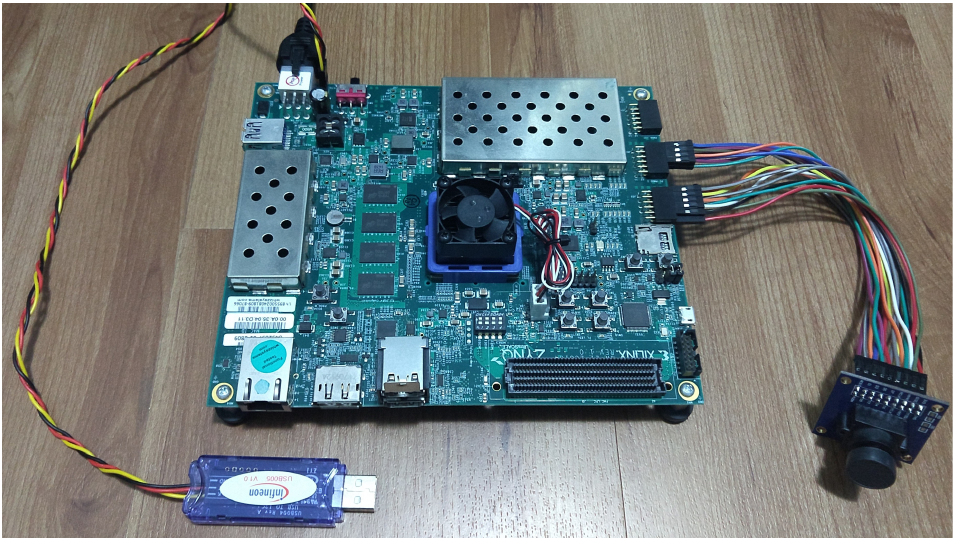
Figure 3. Photography of the Xilinx ZCU104 development kit with the OV7670 CMOS sensor and the Infineon power monitor